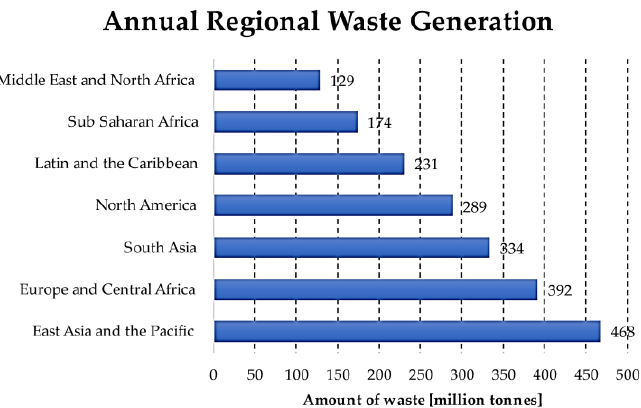
Figure 2. European Union Food Waste Generation (modified after [36]).